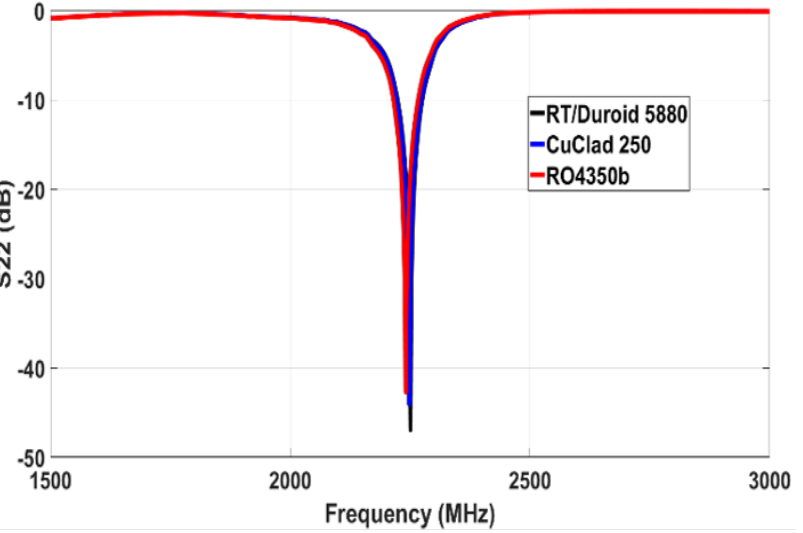
Figure 7. Output reflection parameter (S 22 ) simulation for the selected RF substrates centered at 2.25 GHz.